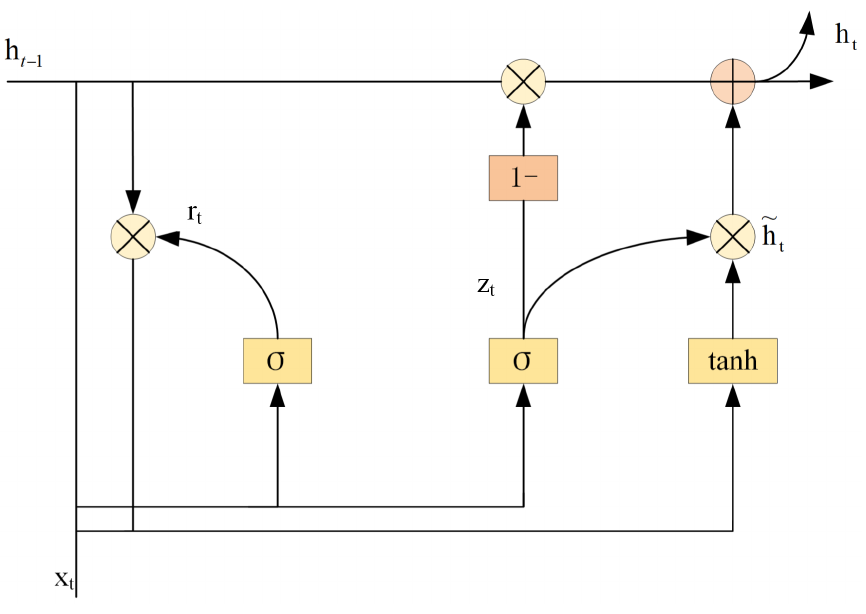
Figure 5. Structural overview of GRU unit.